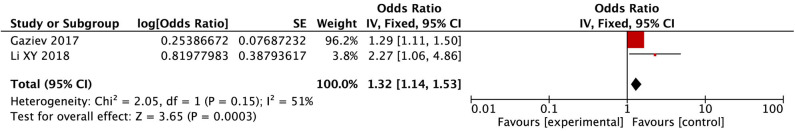
Forest plot for the incidence of acute GVHD. There is no obvious heterogeneity between the 2 records.